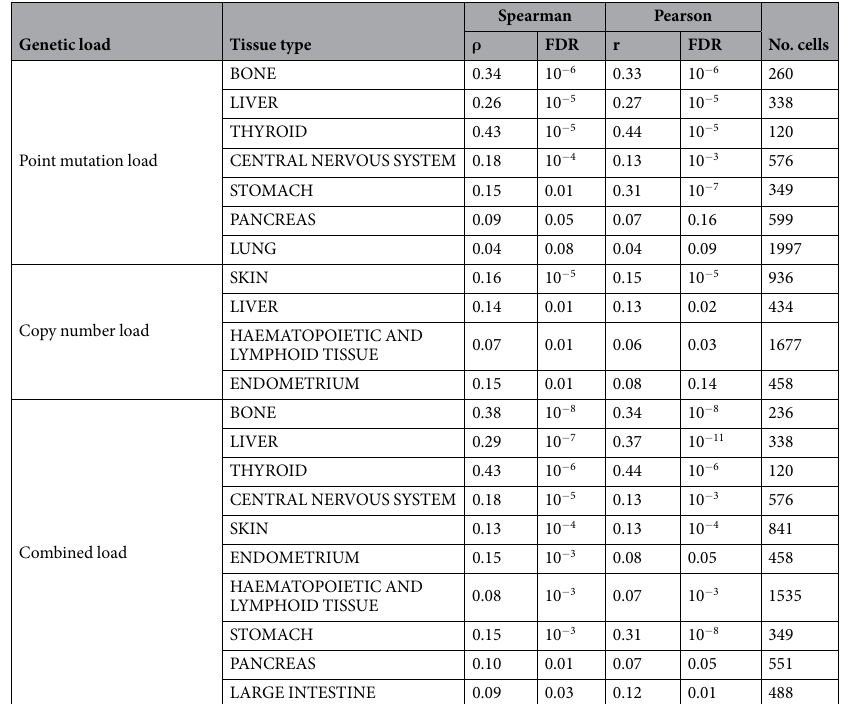
Table 3. Significant associations for the pan-drug